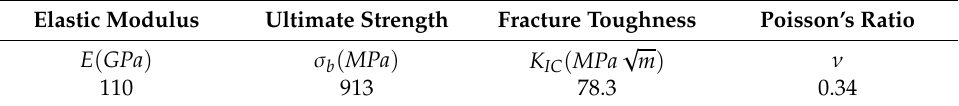
Figure 17. The finite element mesh of the entity and local crack front of the model. Table 4. Mechanical properties of Ti-6Al-4V.